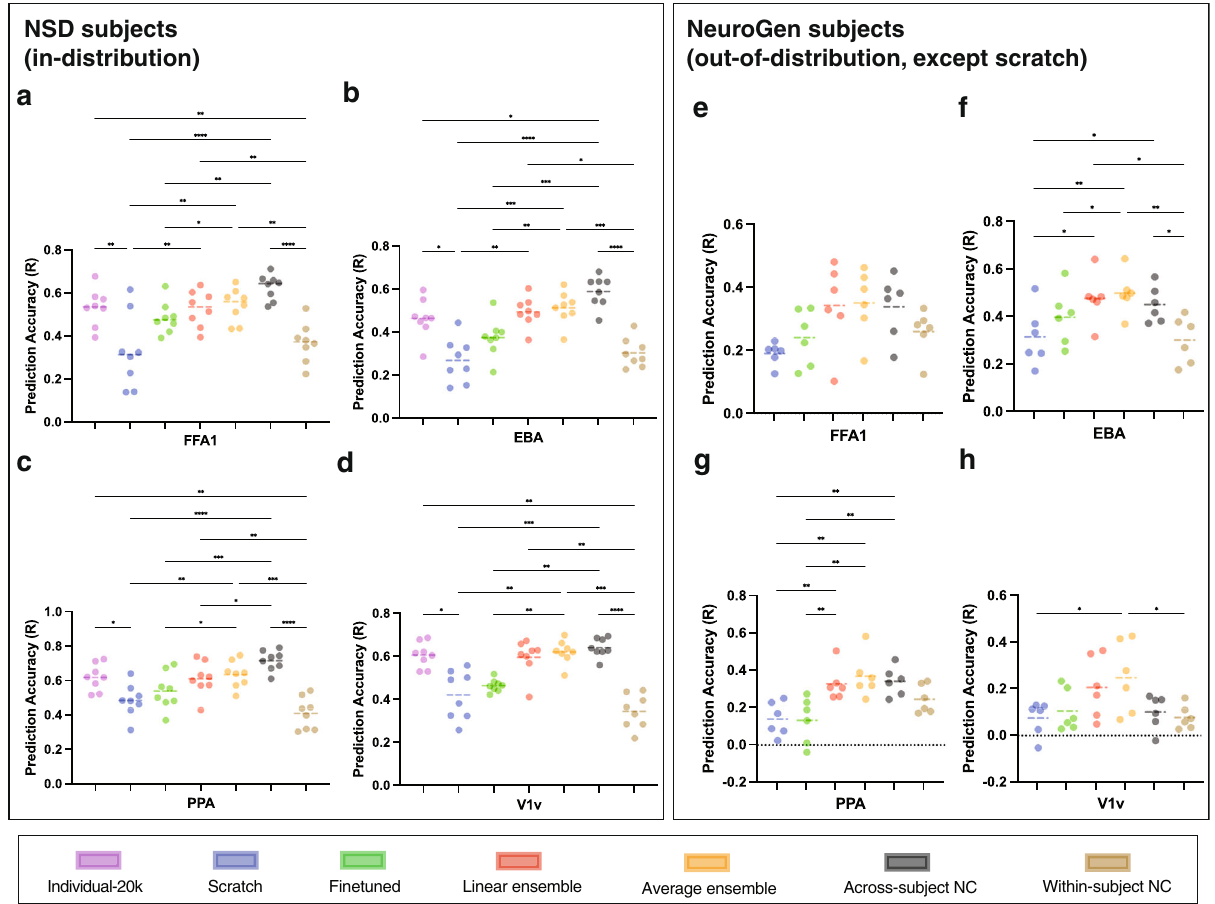
Fig. 3 Encoding model prediction accuracies. Accuracies for the 8 NSD individuals a FFA1, b EBA, c PPA, d V1v, and 6 NeuroGen subjects e FFA1, f EBA, g PPA, h V1v, measured via Pearson ’ s correlation between predicted and observed regional activity across a set of test images for 4 regions - FFA1, EBA, PPA and V1v. Individual-20K models are illustrated in purple, scratch models in blue, fi netuned in green, linear ensemble in orange and average ensemble in yellow. Scratch, fi netuned and linear ensemble models were trained with a dataset of 300 image-response pairs from the novel subject in question. The across-subject noise ceiling (NC), representing the correlation between the average measured test-set responses of the other subjects with the measured test-set responses of the subject in question, and within-subject NC, representing the correlation of the individual ’ s measured image responses, are shown in black and brown, respectively. Black bars at the top of the panels indicate signi fi cant differences in accuracy across the indicated pairs of models (Friedman ’ s test with FDR corrected p < 0.05). The correspondence between the number of asterisks and the p -value: * - p ≤ 0.05, ** - p ≤ 0.01, *** - p ≤ 0.001, **** - p ≤